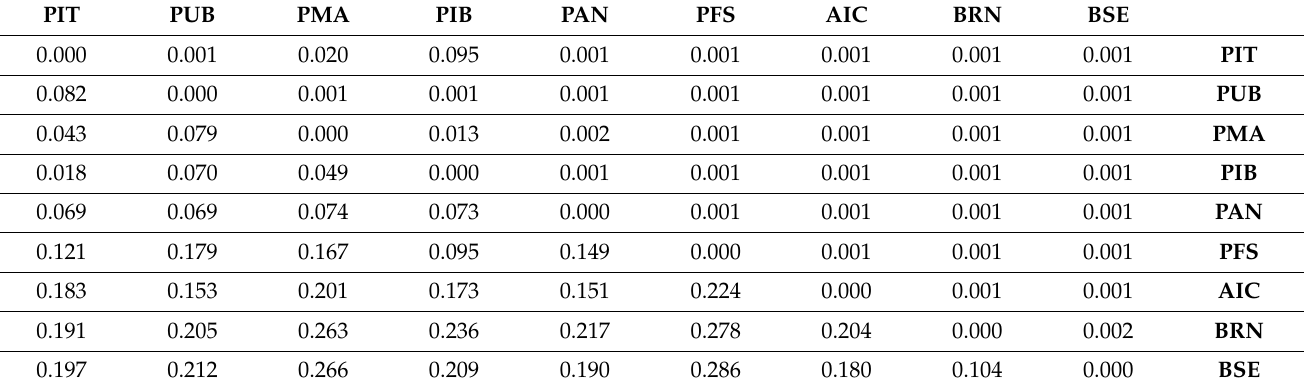
Table 3. Pairwise Φ ST between Raddia populations below the diagonal and p -values above the diagonal. For population codes see the sampling subitem on Section